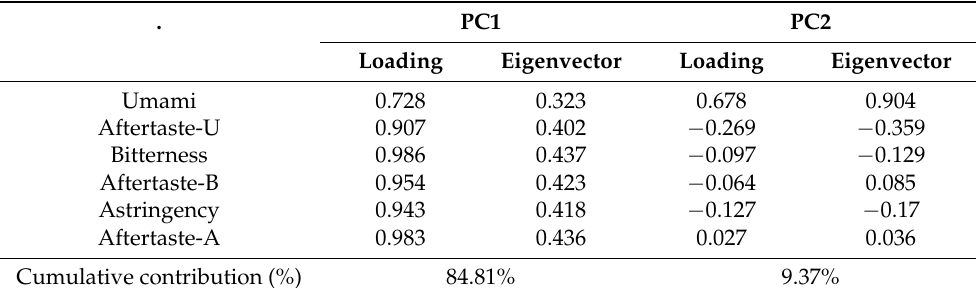
Table 3. Loading matrix, eigenvector, and cumulative contribution of the principal components of the taste values of umami, aftertaste-U, bitterness, aftertaste-B, astringency, and aftertaste-A in the hepatopancreas of June hairy crabs.